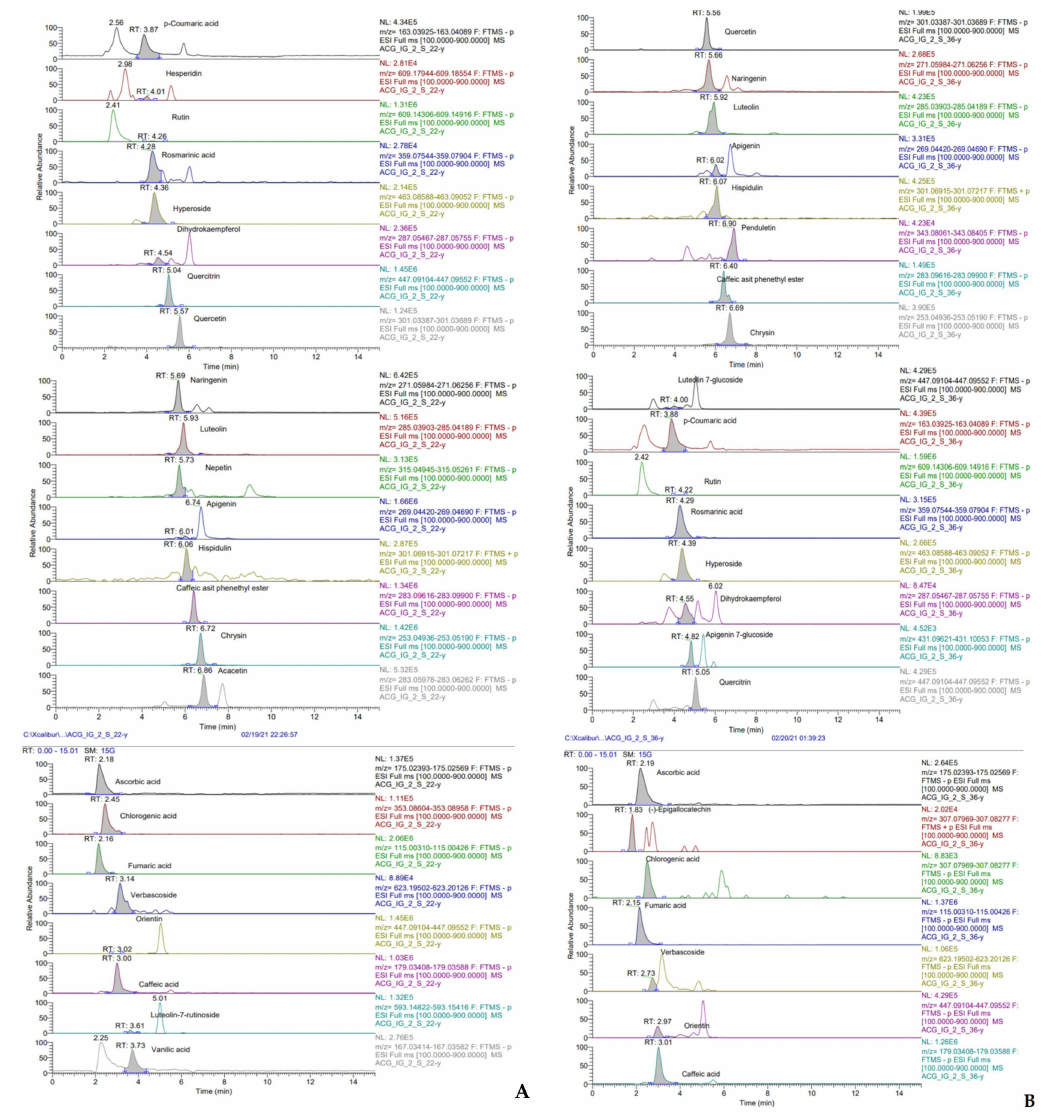
Figure 3. LC-MS/MS chromatograms of EDOA ( A ) and EDOR ( B ) from sahlep ( D. osmanica ) (EDOA: ethanol extract of D. osmanica aerial parts, EDOR: ethanol extract of D. osmanica